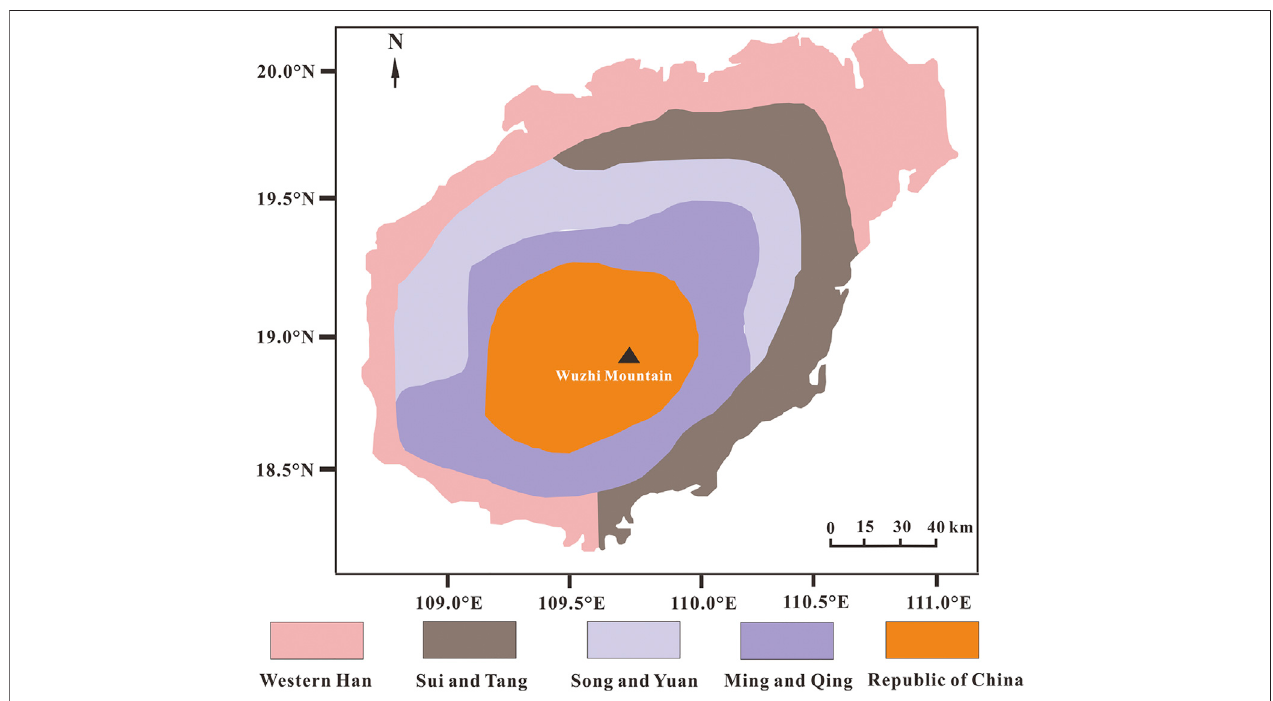
FIGURE 7 | Map depicting the historical exploitation of Hainan Island over past dynasties (redrawn from Situ. (1987) with minor modi fi cations).